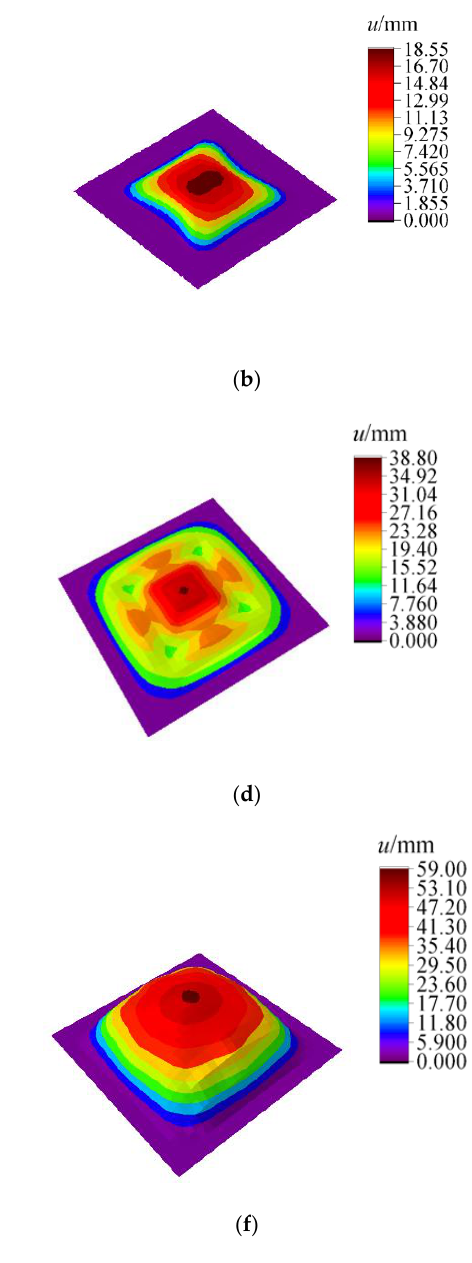
Figure 13. Comparison of deformation distribution between tests and FEA. ( a ) Measured results from tests (2.5 g TNT). ( b ) Predicted results from FEA (2.5 g TNT). ( c ) Measured results from tests (5 g TNT). ( d ) Predicted results from FEA (5 g TNT). ( e ) Measured results from tests (10 g TNT). ( f ) Predicted results from FEA (10 g TNT).